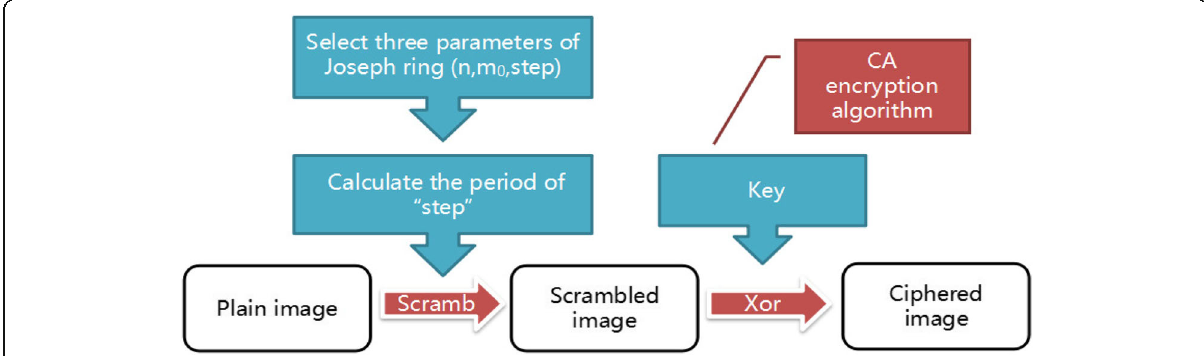
Fig. 1 Overall structure of the encryption